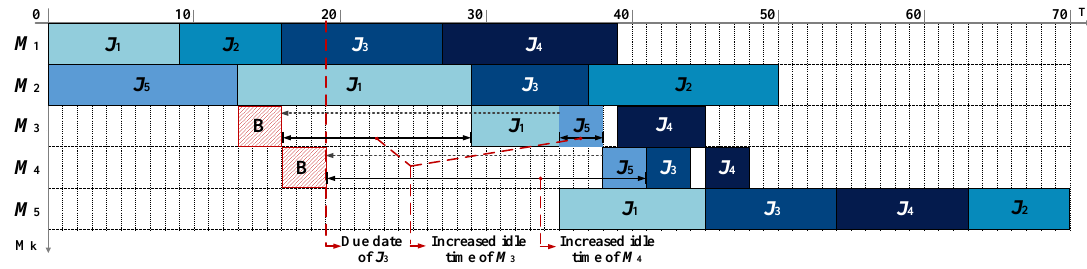
Figure 2. An exemplifying situation for the conflict between NPE and TF.